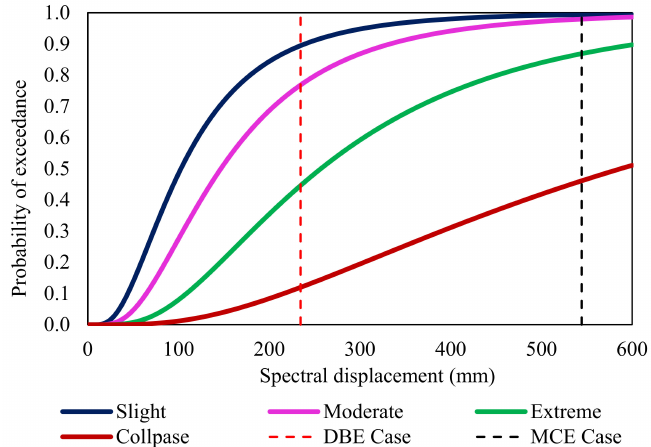
Figure 14. Fragility curve for unsymmetrical building Case III (R = 5).